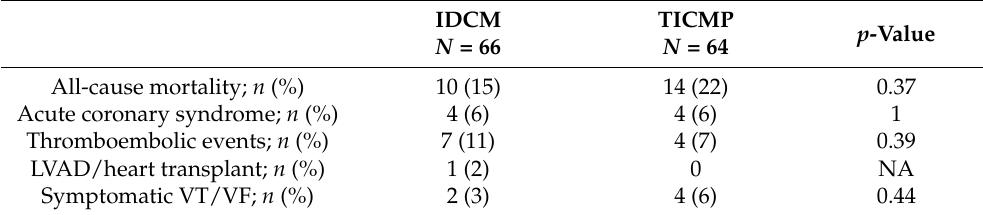
Table 3. Composite outcome events.